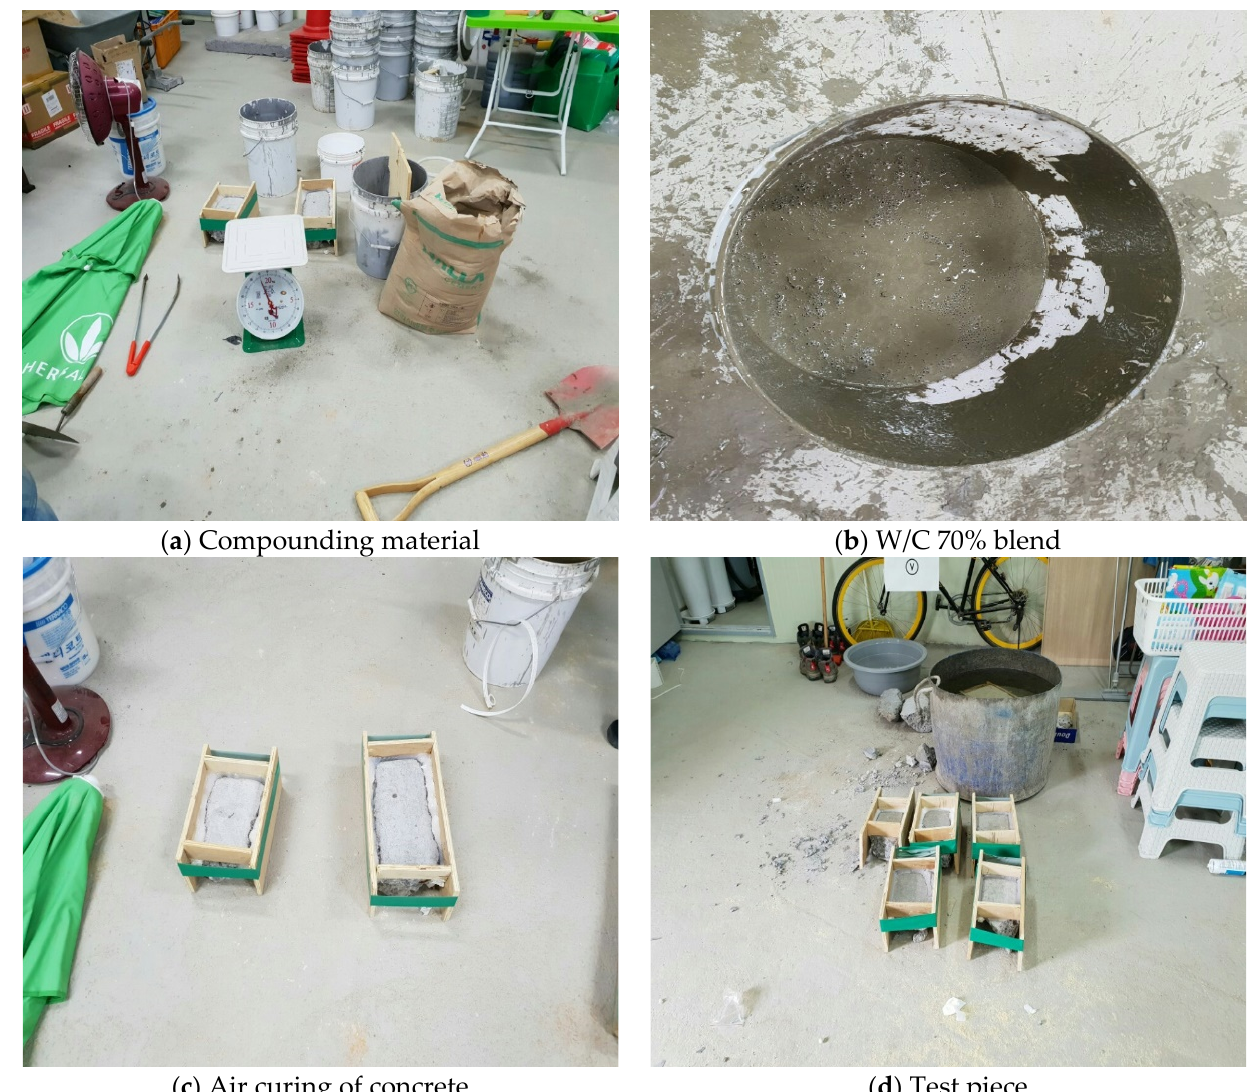
Figure 5. Test piece production process.